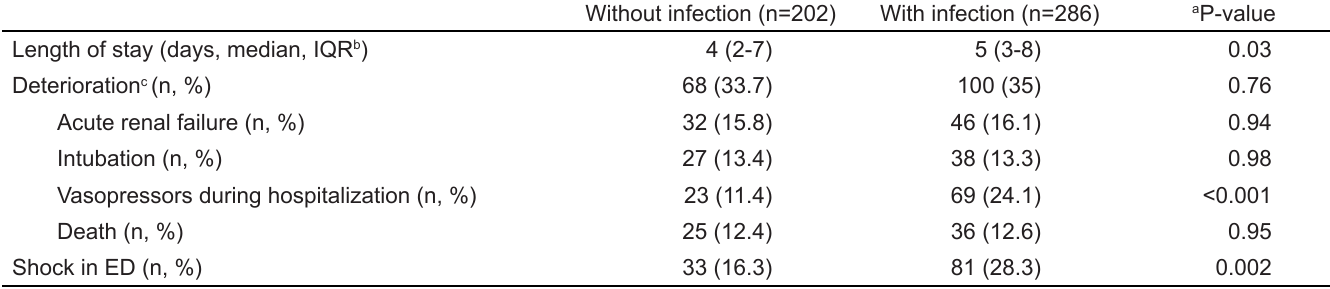
Table 3. Outcome measures in the population of ED